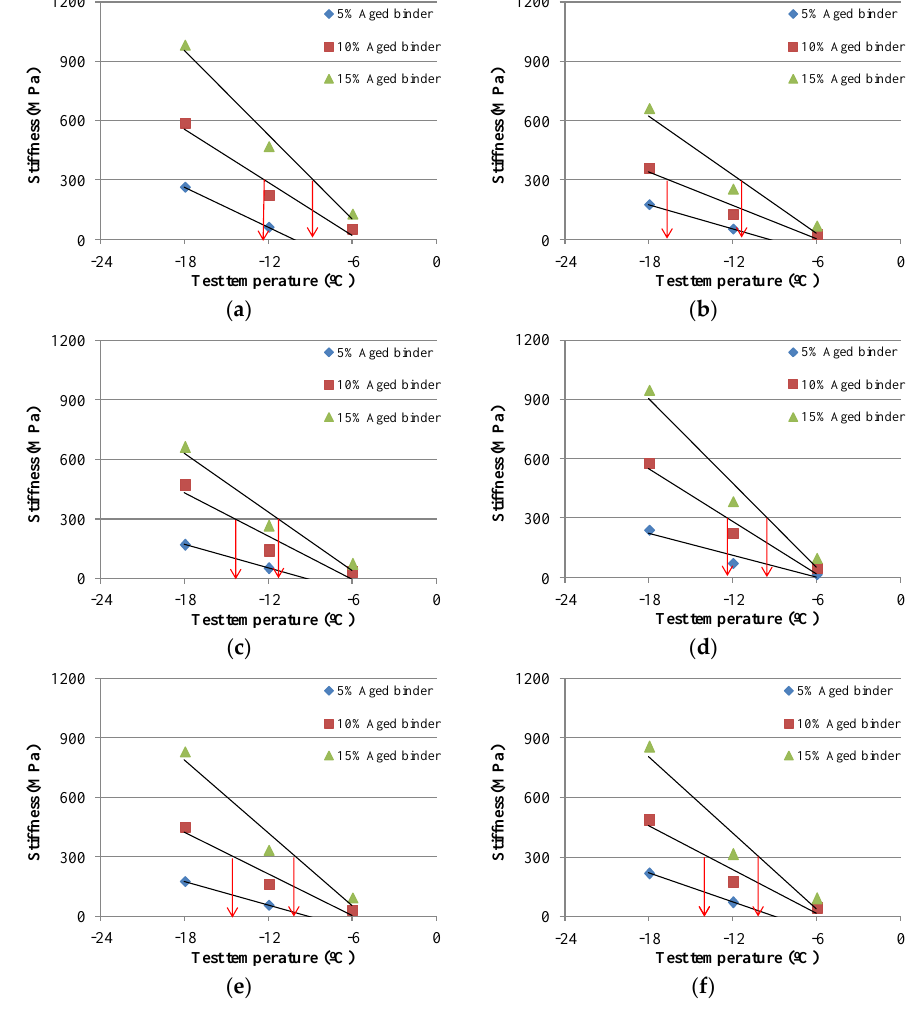
Figure 2. Low temperature determinations of RAP sources A–F with virgin binder PG 58-22 in terms of stiffness, ( a – f ) RAP sources A–F.